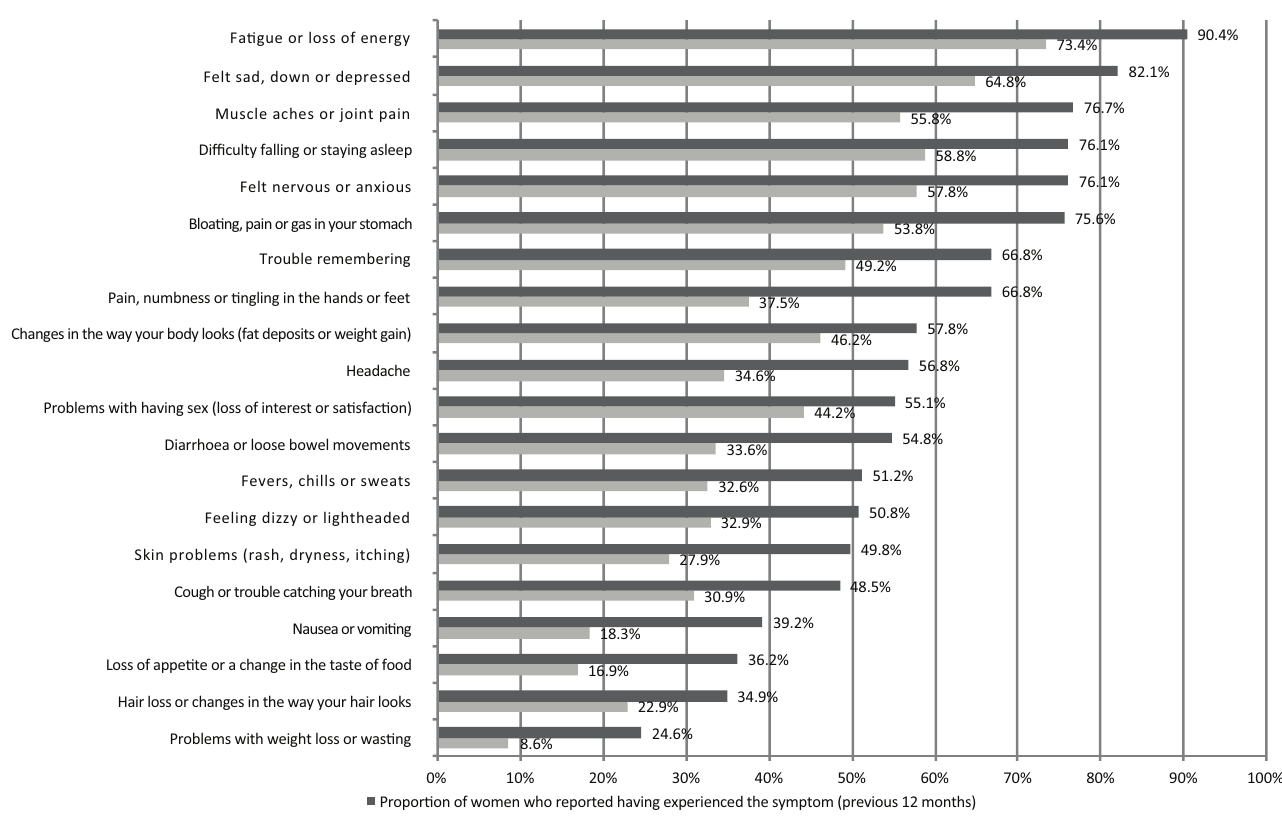
Fig 1. Proportion of women who reported having experienced the symptom during the previous 12 months and the proportion of women who reported having found the symptom bothersome: the EVE study (France, 2014).